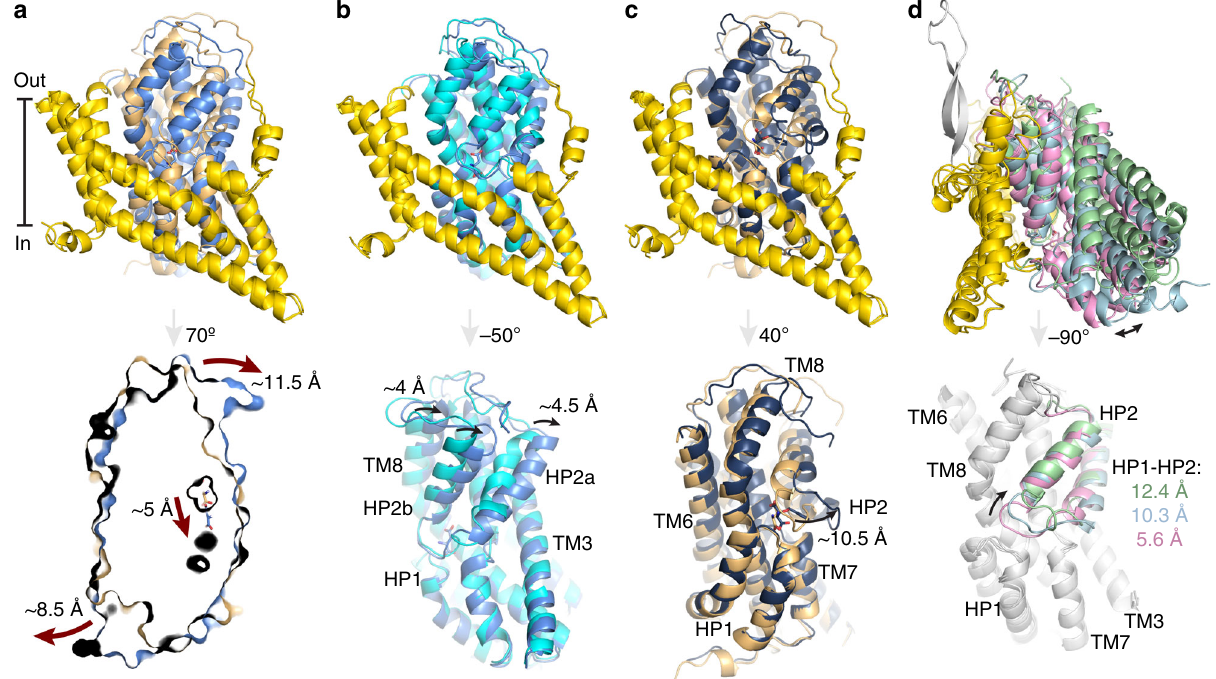
Fig. 3 Conformational differences of the Glt Tk protomers. a Comparison of the holo (Asp) Glt Tk cryo-EM (corn fl ower blue) and crystal (PDB 5E9S, light orange) 12 structures (superposition using scaffold domains (yellow)) demonstrates differences between the fully outward and intermediate outward states. The panel below shows a slice through the transport domains in surface representation with aspartate molecules shown as sticks. The arrows indicate the movement of the transport domain from the fully-outward to intermediate-outward position. b Superposition on the scaffold domains of the cryo-EM structures of Glt Tk - holo (Asp) (corn fl ower blue) and Glt Tk - apo (cyan), which are both in intermediate-outward conformations. The lower panel shows the transport domains rotated 50° relative to the upper panel to highlight structural differences. c Superposition on the scaffold domains of cryo-EM structure of Glt Tk -TBOA (dark blue) and crystal structure Glt Tk -Asp (PDB 5E9S, light orange). The lower panel shows the transport domains rotated 40° relative to the upper panel with an arrow indicating opening of the HP2 gate. d Superposition of the cryo-EM structure of Glt Tk -Na + -only (light blue), the cryo-EM structure of ASCT2 (PDB 6RVX, light green) 17 , and a crystal structure of Glt Ph -Asp in the inward-oriented state (PDB 3KBC, pink) 10 . The lower panel highlights opening of the HP2 gate in the inward-oriented state. Superpositions on TM2 and TM5 of the scaffold